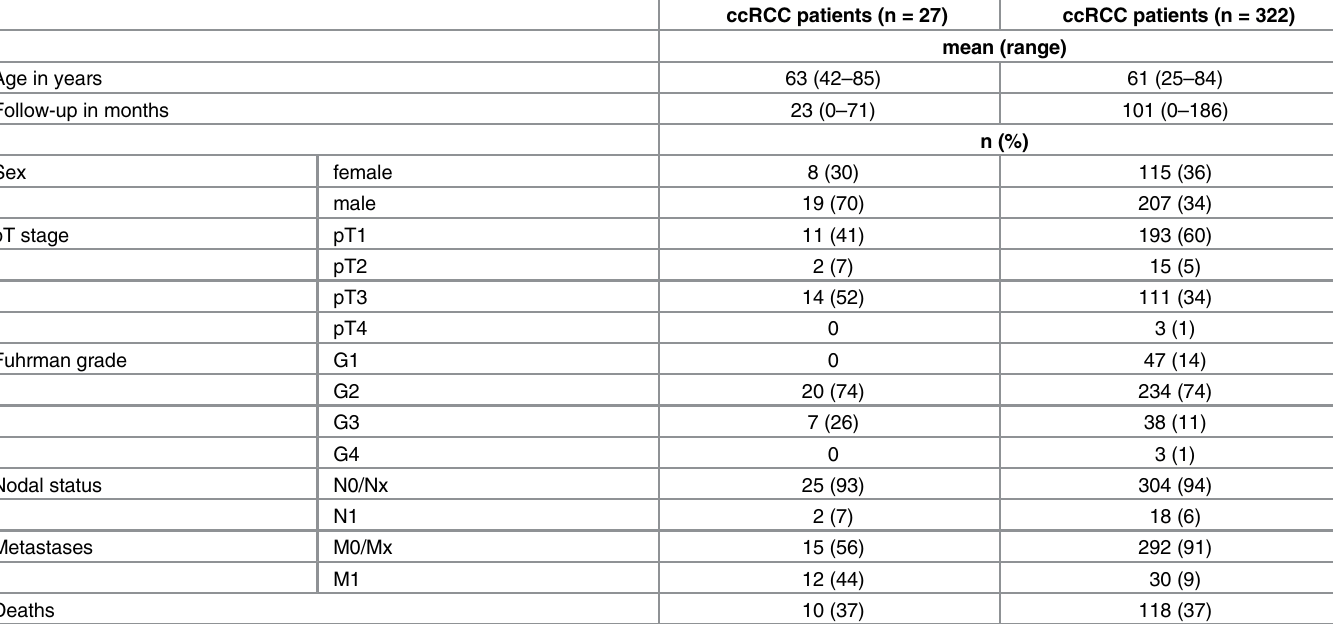
Table 1. Clinicopathological patient